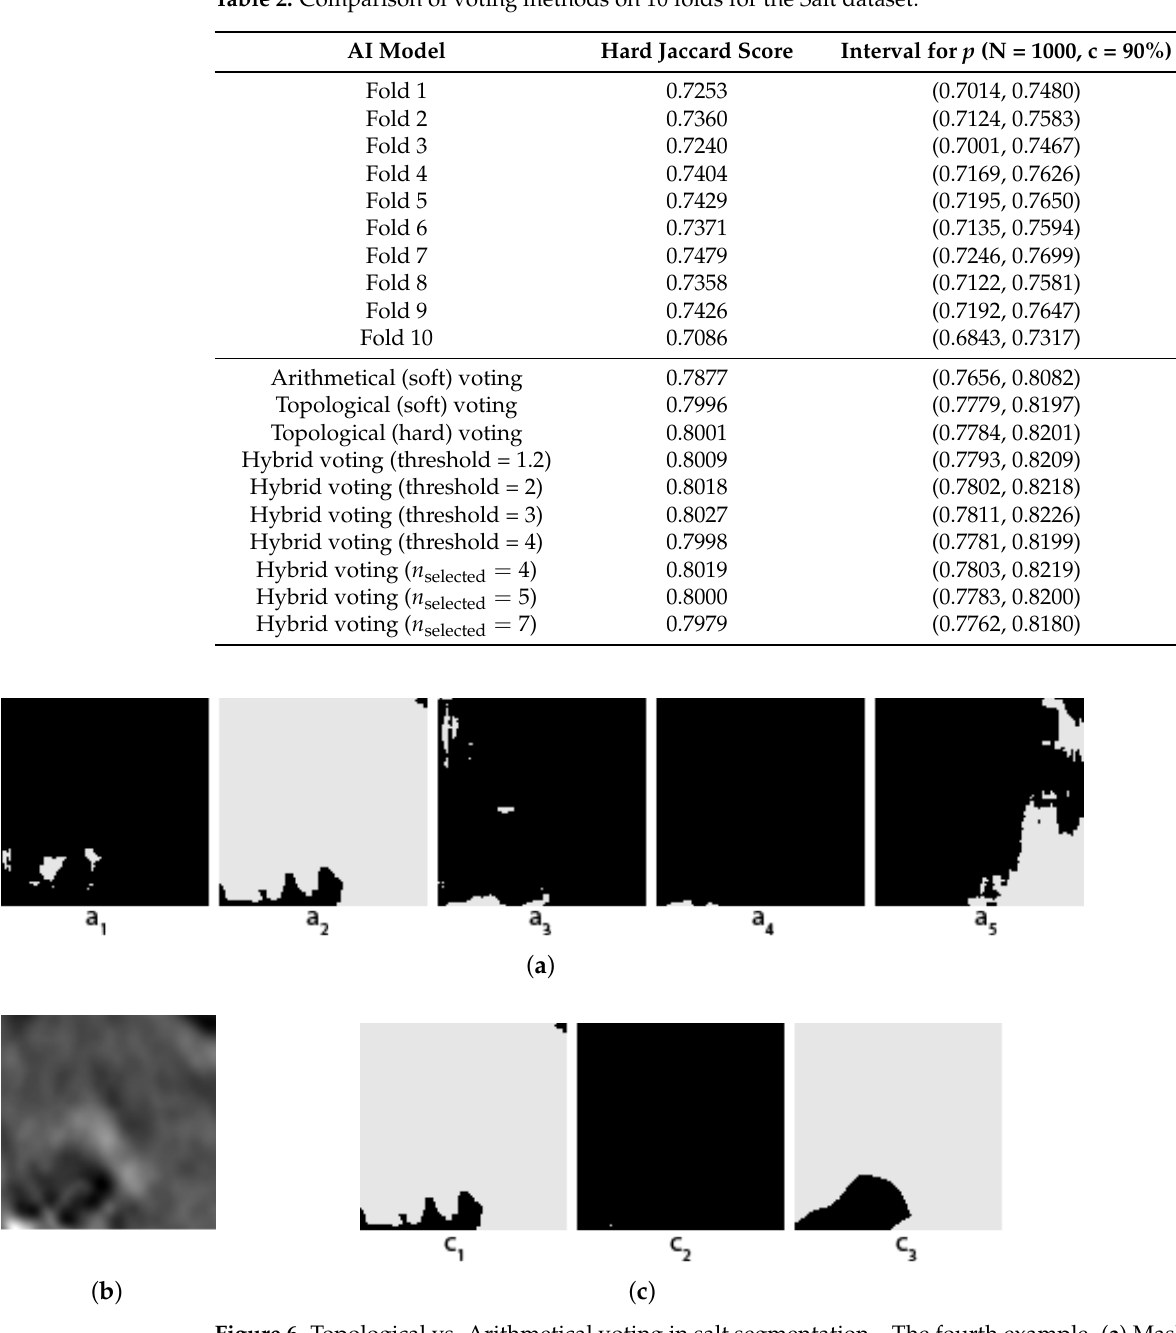
Figure 6. Topological vs. Arithmetical voting in salt segmentation—The fourth example. ( a ) Masks created by 5 individual segmentors (from 5 folds); ( b ) Original image; ( c ) C 1 : Topological voting, C 2 : Arithmetical voting, C 3 : True mask.